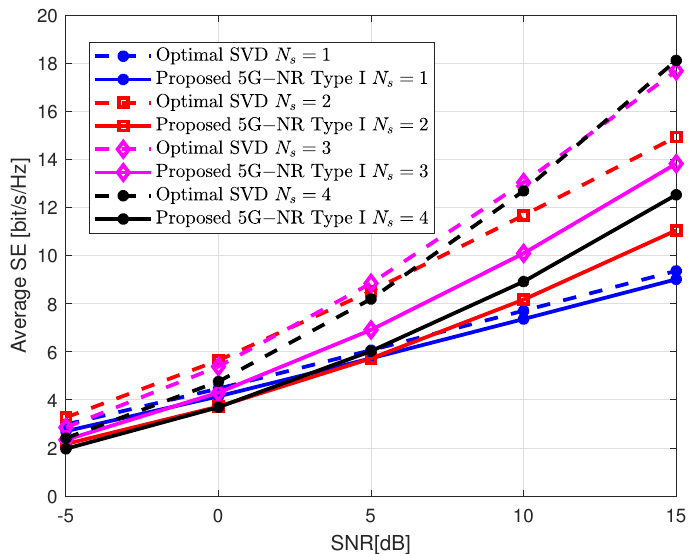
Figure 4. Average SE vs. SNR for SU-MIMO systems assuming 𝑁 𝑡 = 8, 𝑁 𝑟 = 4, and different values of 𝑁 𝑠 . The gNB is implemented assuming a single-panel ULA with four DP polarized antenna elements in the horizontal dimension ( 𝑁 1 = 4 and 𝑁 2 = 1).